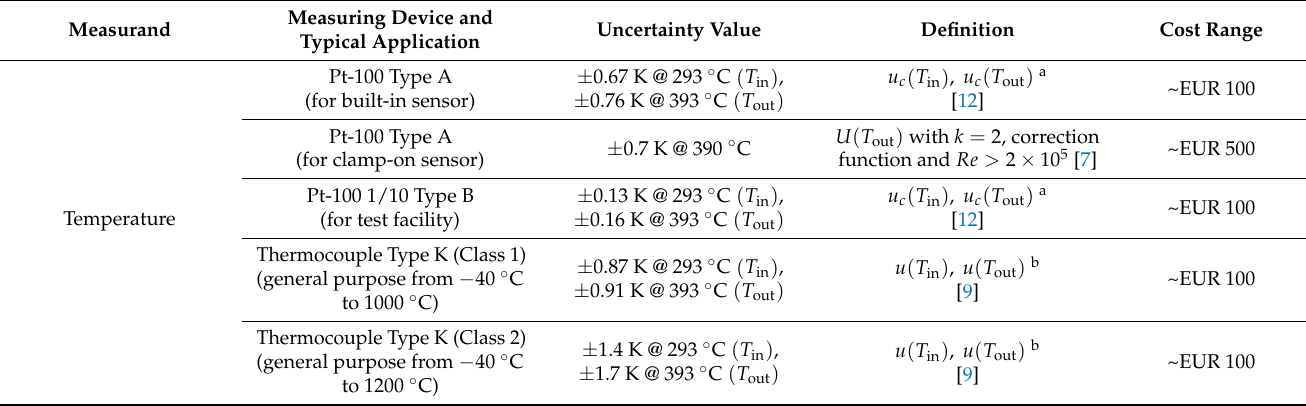
Table 1. Measurand, measuring device, measuring uncertainty and approximate cost range for standard HTF measurements in parabolic trough collector fields.